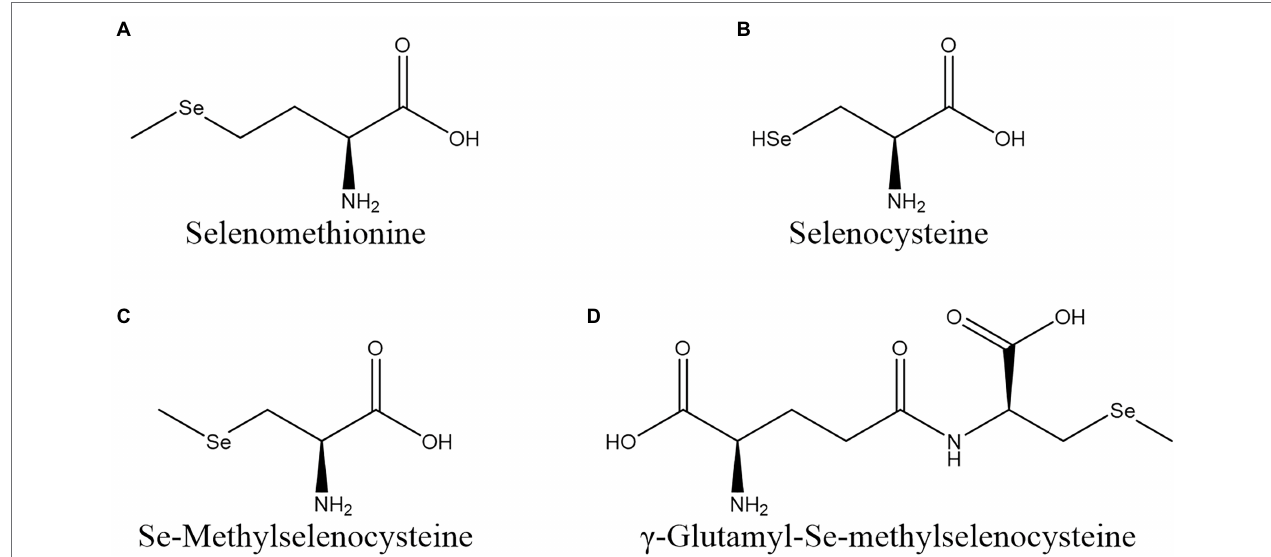
FIGURE 1 | Structures of seleno-amino acids commonly found in vegetables. (A) SeMet; (B) SeCys; (C) MeSeCys; and (D) γ